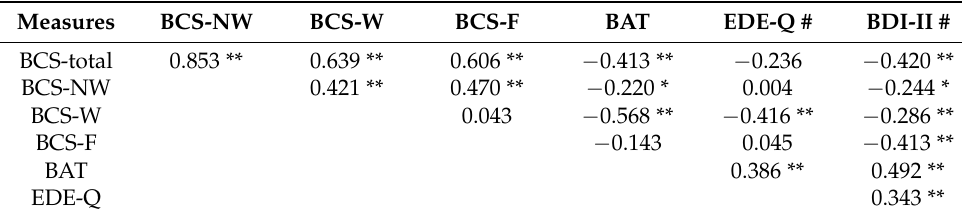
Table 3. Correlation matrix for the pre-treatment measurements.